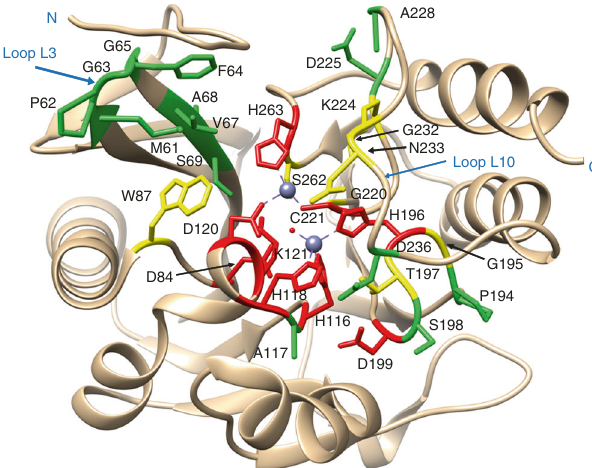
Fig. 4 Diagram of the NDM-1- β -lactamase structure showing the location of essential, substrate-speci fi c, and non-essential residues. Essential, substrate-speci fi c, and non-essential residues are labeled red, yellow, and green, respectively, whereas the zinc atoms are represented as gray spheres. The fi gure was rendered using coordinates from the Protein Data